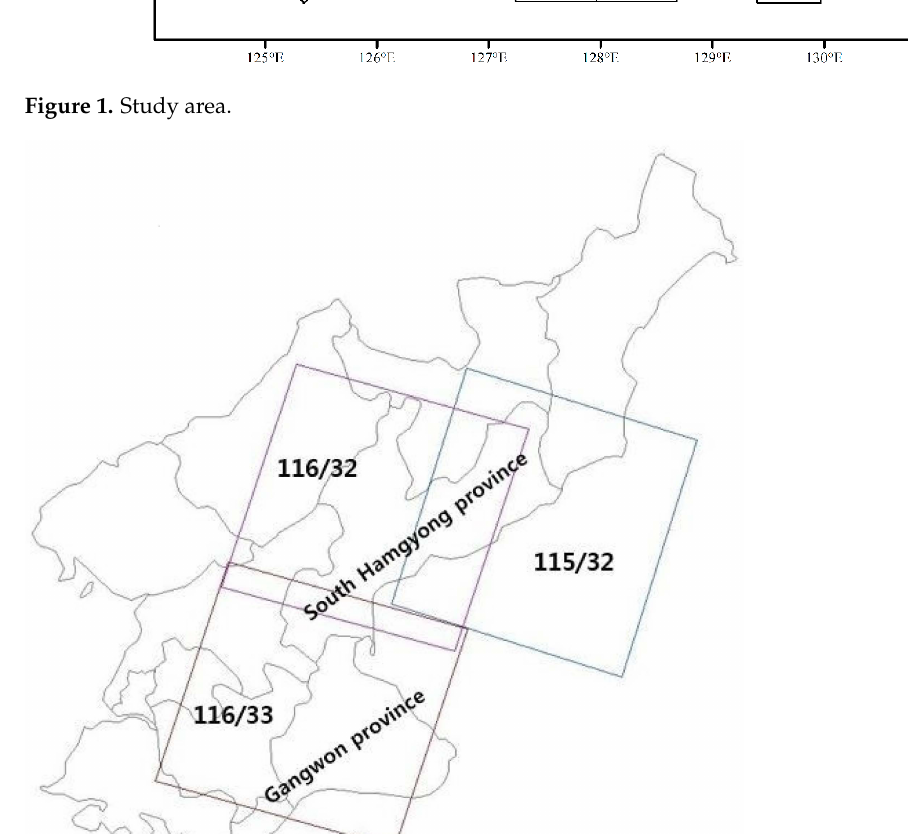
Figure 2. The path and row numbers of Landsat orbits that cover GWP and SHP.